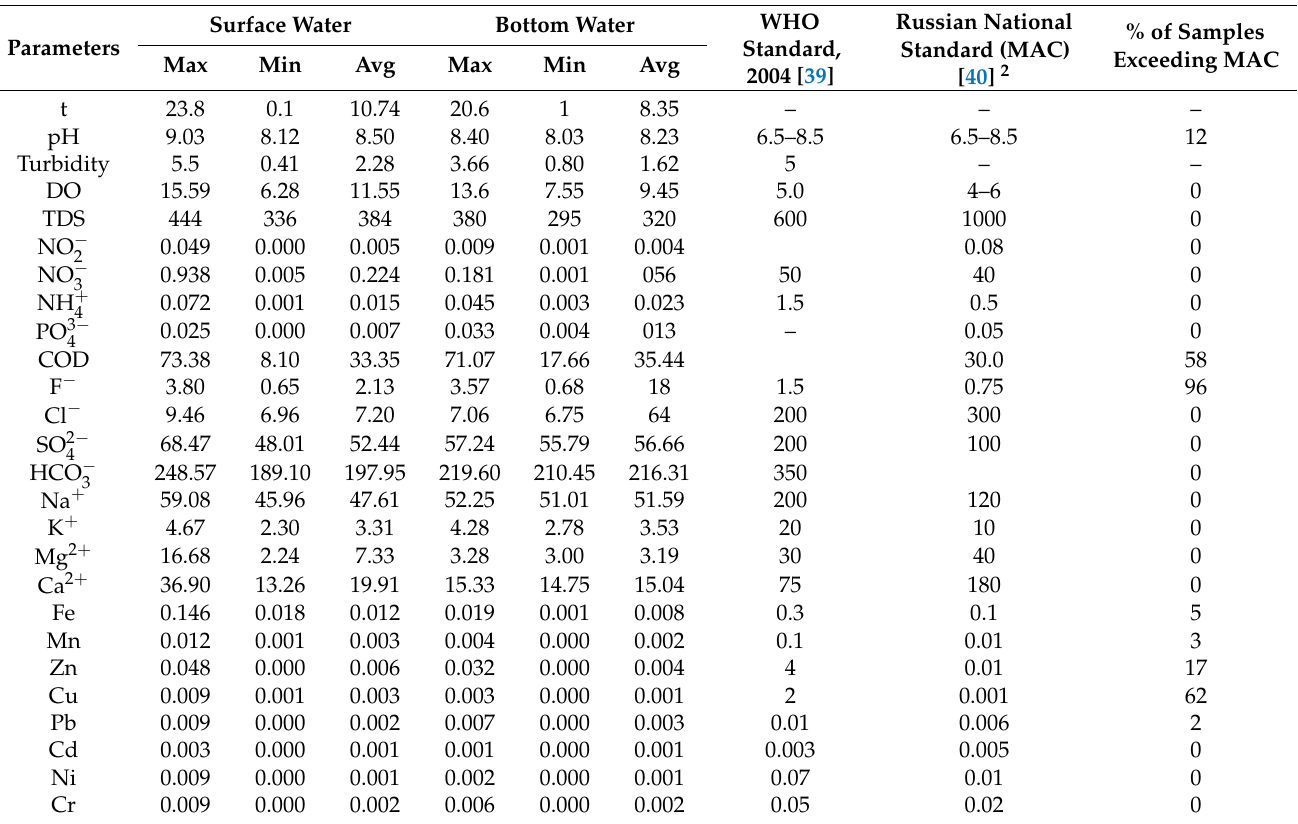
Table 2. The maximum, minimum and average content of chemical components in the surface and bottom waters of Lake Gusinoe 1